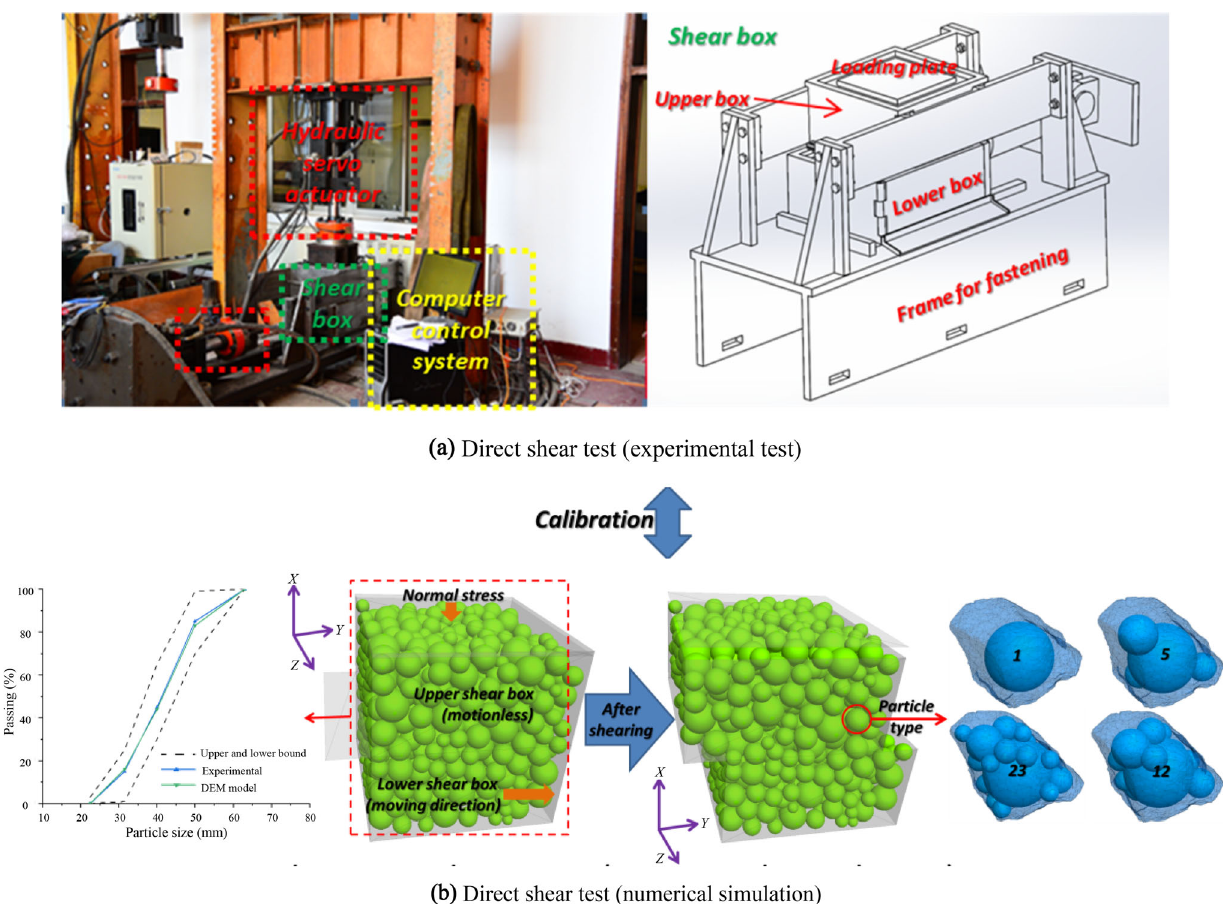
Fig. 1 Schematic diagram of the applied